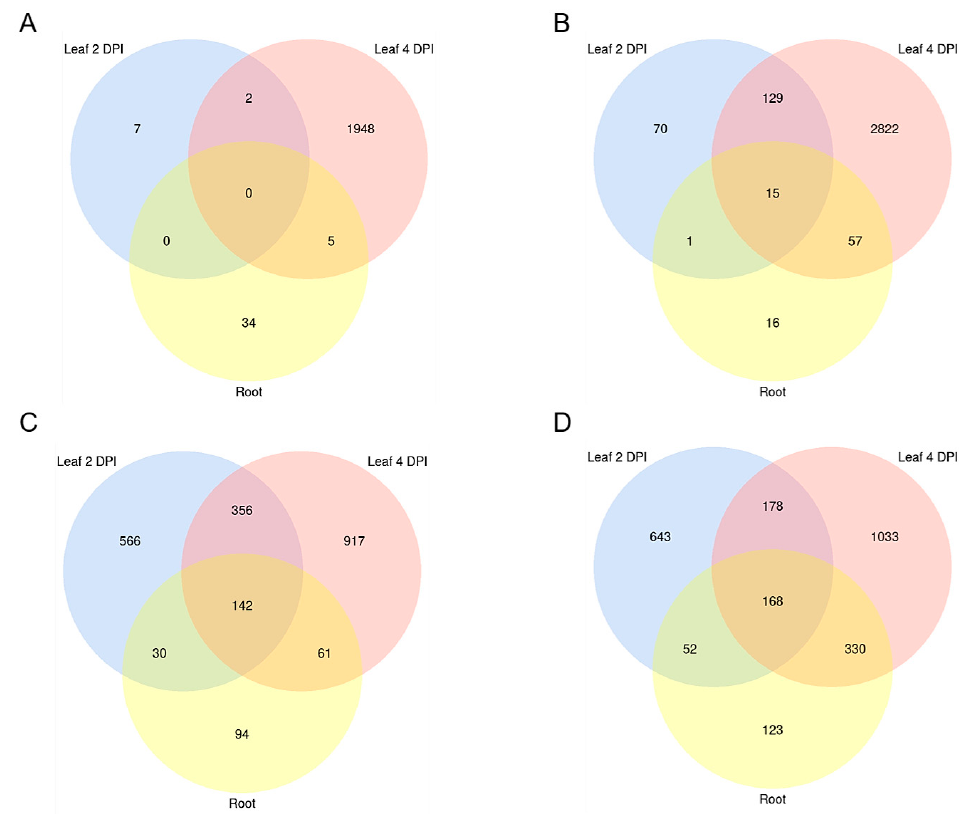
Figure 5. Venn diagram of differentially expressed B. distachyon and M. oryzae genes. Significantly ( A ) downregulated (fold change (FC) < 0 padj < 0.05) and ( B ) upregulated (FC > 0 padj < 0.05) Bd genes shared between setups. Significantly ( C ) downregulated (FC < 0 padj < 0.05) and ( D ) upregulated (FC > 0 padj < 0.05) Mo genes shared between setups (“Leaf 2 DPI”, “Leaf 4 DPI” and “Root”). Transcript downregulation was calculated from mRNAseq data with